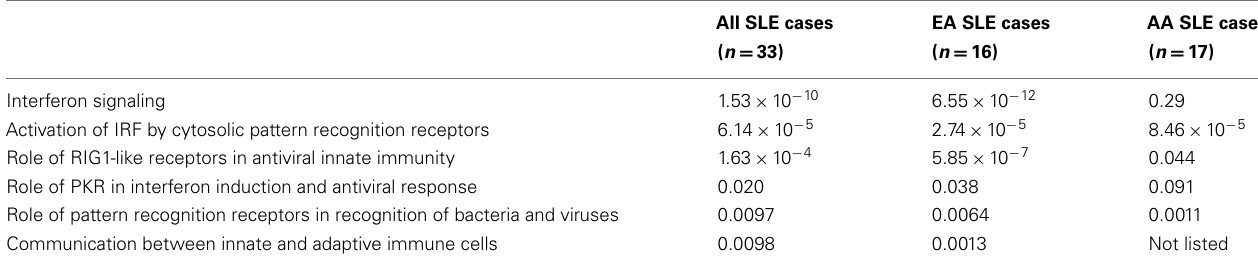
Table 3 | P values for IPA IFN-related canonical pathways from microarray data.